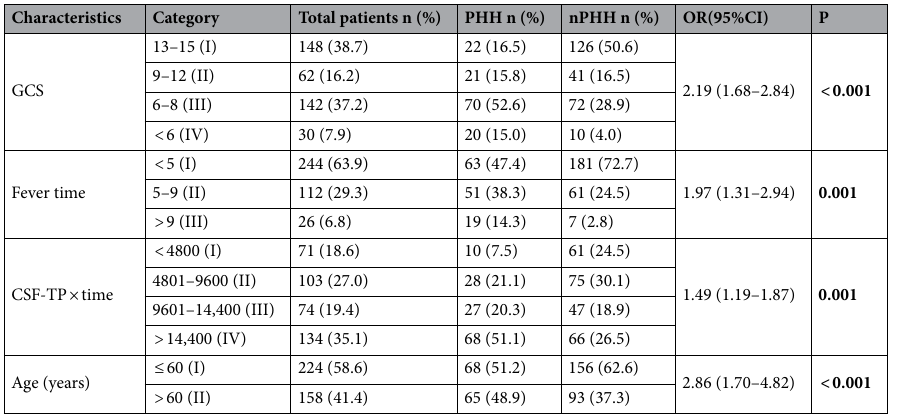
Table 2. Multivariate analysis of that p < 0.05. PHH post-hemorrhagic hydrocephalus, nPHH not post- hemorrhagic hydrocephalus, GCS Glasgow coma score, CSF-TP × time Cerebrospinal fluid total protein × time, OR odds ratio, CI confidence interval. *p < 0.05 means statistical significance.